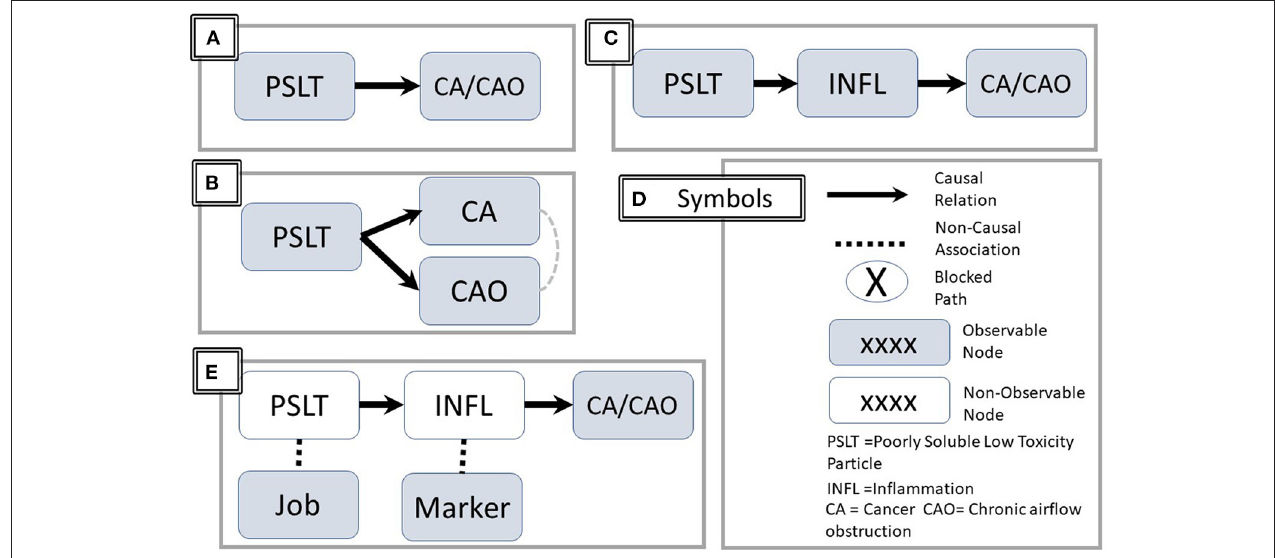
FIGURE 1 | Directed Acyclic Graph (DAG) representations. The figure illustrates three causal sequences: (A) PSLT causes CA and CAO (solid line with arrowhead). (B) Clarification–the causation of CA and CAO are independent. However, a noncausal association may be observed between CA and CAO (dashed line without arrow). (C) PSLT acts through the mediator of inflammation. (D) Summary of representational symbols. (E) PSLT and INFL are indirectly assessed by associated job and biomarkers respectively. Unfilled nodes are not directly observable. PSLT, poorly soluble low toxicity particles; CA, cancer; CAO, chronic airflow obstruction; INFL,